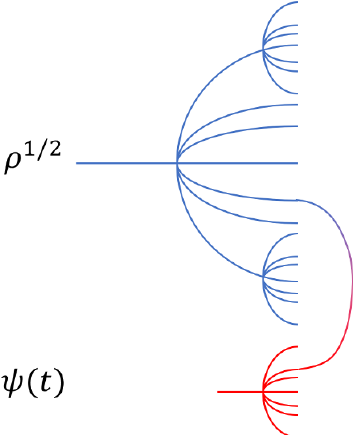
Figure 5 . At (cid:12)nite temperature, when an operator such as 1 ( t ) is multiplied to (cid:26) 1 = 2 , there is a chance that some fermion (cid:13)avors collide and the size increase is smaller than the size of 1 ( t ) itself. At in(cid:12)nite temperature (cid:12) ! 0, G ( (cid:12)= 2) = 1, which restores the trivial result that